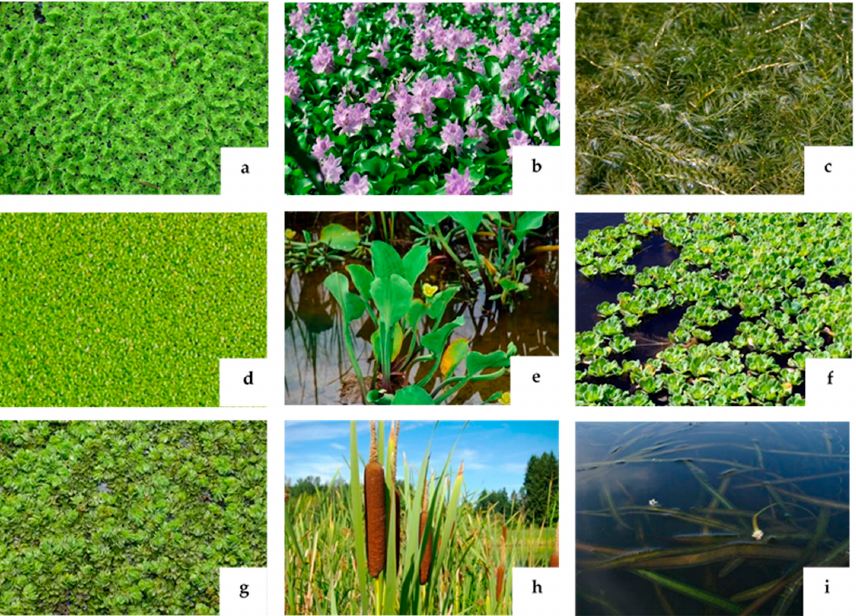
Figure 2. Common aquatic weeds found in Sri Lankan aquatic ecosystems: a. Azolla spp; b. Eich- hornia crassipes; c. Hydrilla verticillata; d. Lemna spp; e. Limnocharis flava; f. Pistia spp.; g. Salvinia mo- lesta; h. Typha spp.; i. Vallisneria spp. [22,24,25]. The majority of aquatic weeds pose risks to agricultural lands, aquatic habitats, and natural and forest ecosystems. A few of them can be listed as follows: